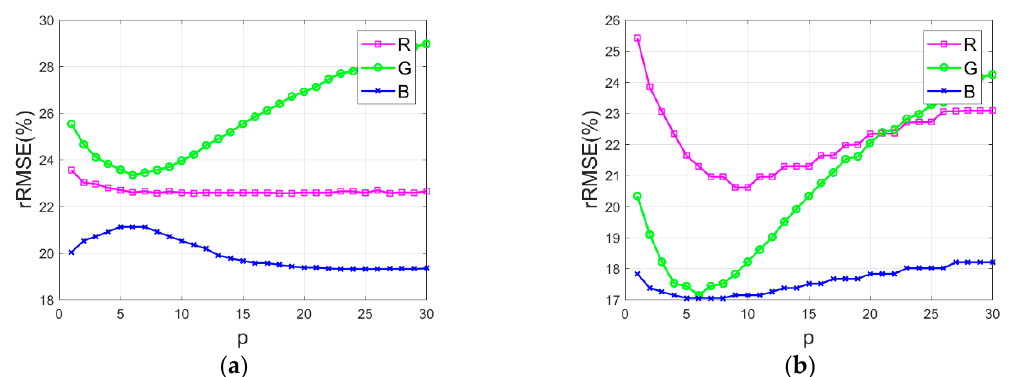
Figure 11. rRMSE of shadow compensation results with various p values for test images. ( a ) Tripoli-1. ( b ) Tripoli-2.